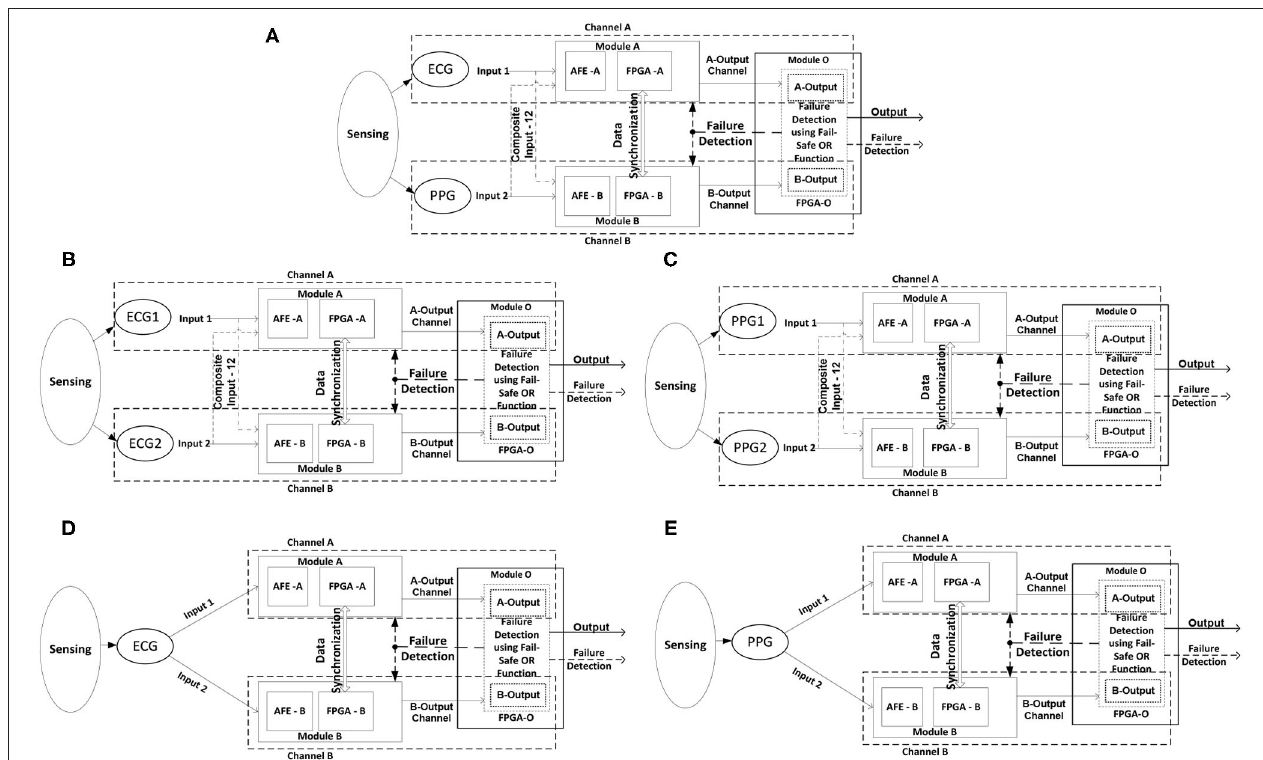
FIGURE 1 | Configurable 2oo2 system. (A) ECG and PPG sensor and diverse algorithm. (B) ECG1 and ECG2 sensor and the same algorithm. (C) PPG1 and PPG2 sensor and the same algorithm. (D) Single ECG sensor and the same algorithm. (E) Single PPG sensor and the same